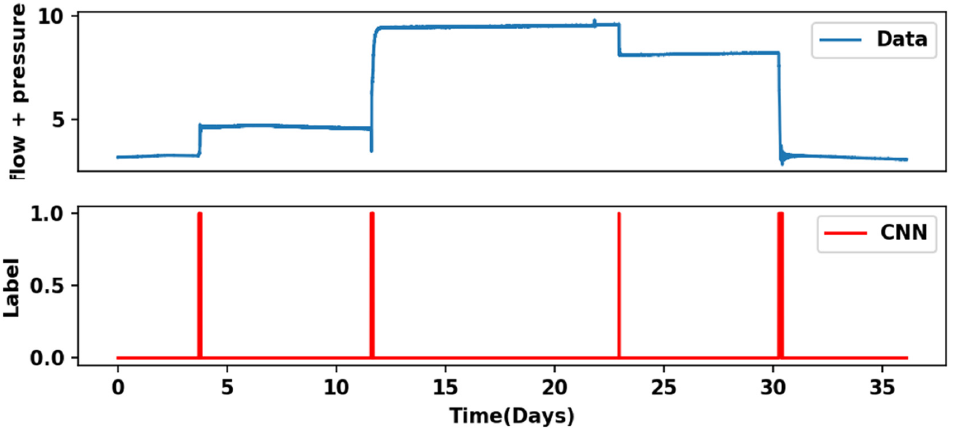
Figure 8. Diagram of CNN autoencoder restoring error value and threshold.